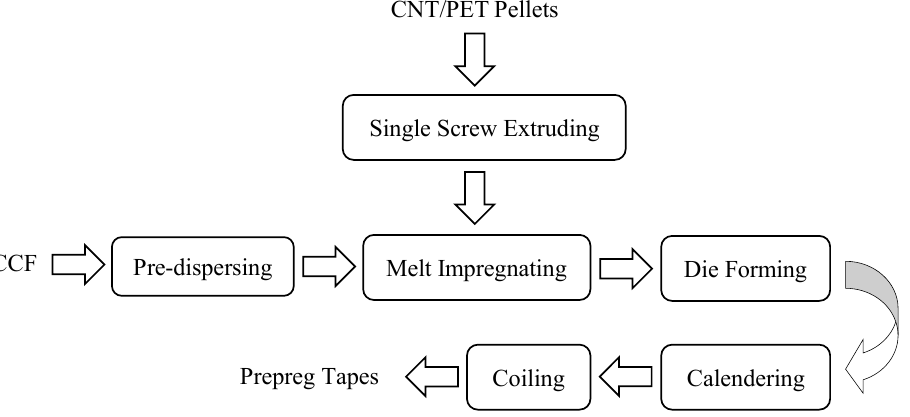
Figure 2. Schematic diagram for process of CNT/CCF/PET prepreg tapes. Table 2. The formula of the prepreg tape.